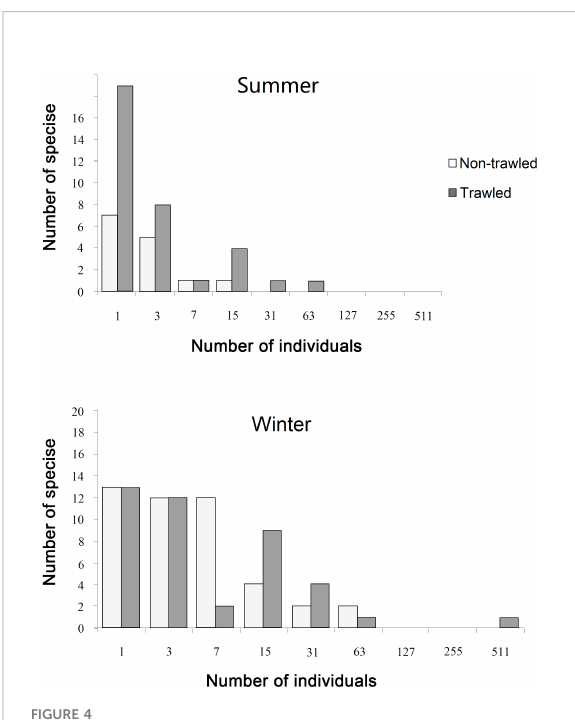
FIGURE 4 Species abundance distribution for each season and each treatment (trawled and non-trawled). The x-axis is in logarithmic scale (modi fi ed log 2 classes). Class 1 represents 1 individual, 3 represents between 2-3 individuals, 7 represents 4-7 individuals, etc.